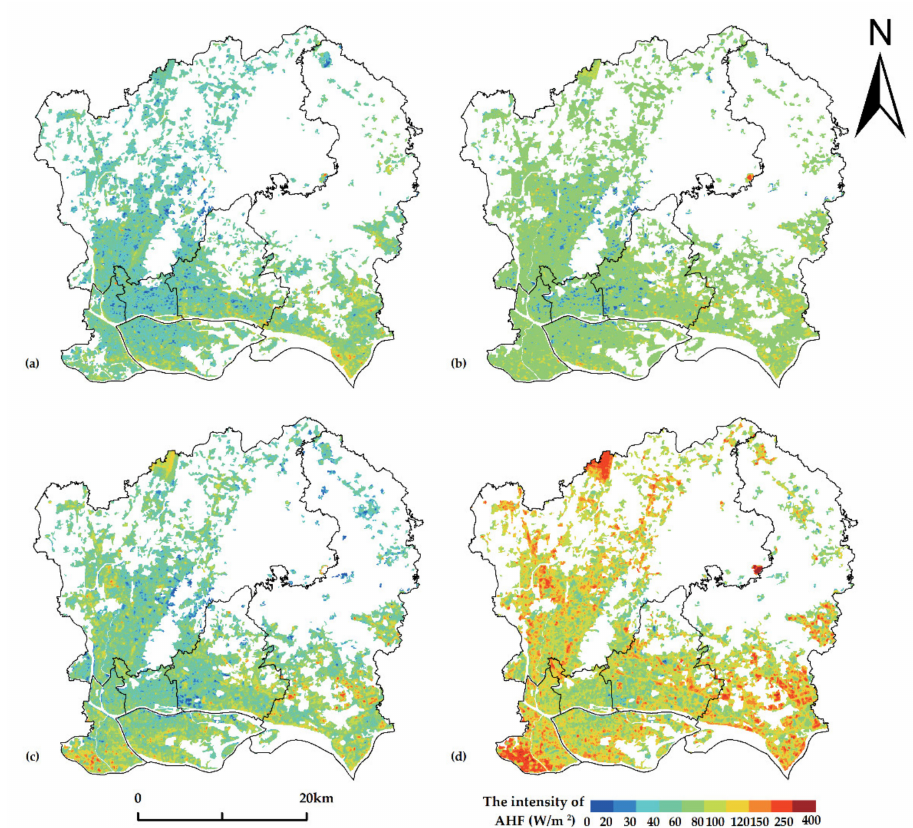
Figure 3. Spatial distribution of anthropogenic heat flux (AHF) ( a ) in 2004, ( b ) in 2009, ( c ) in 2014, and ( d ) in